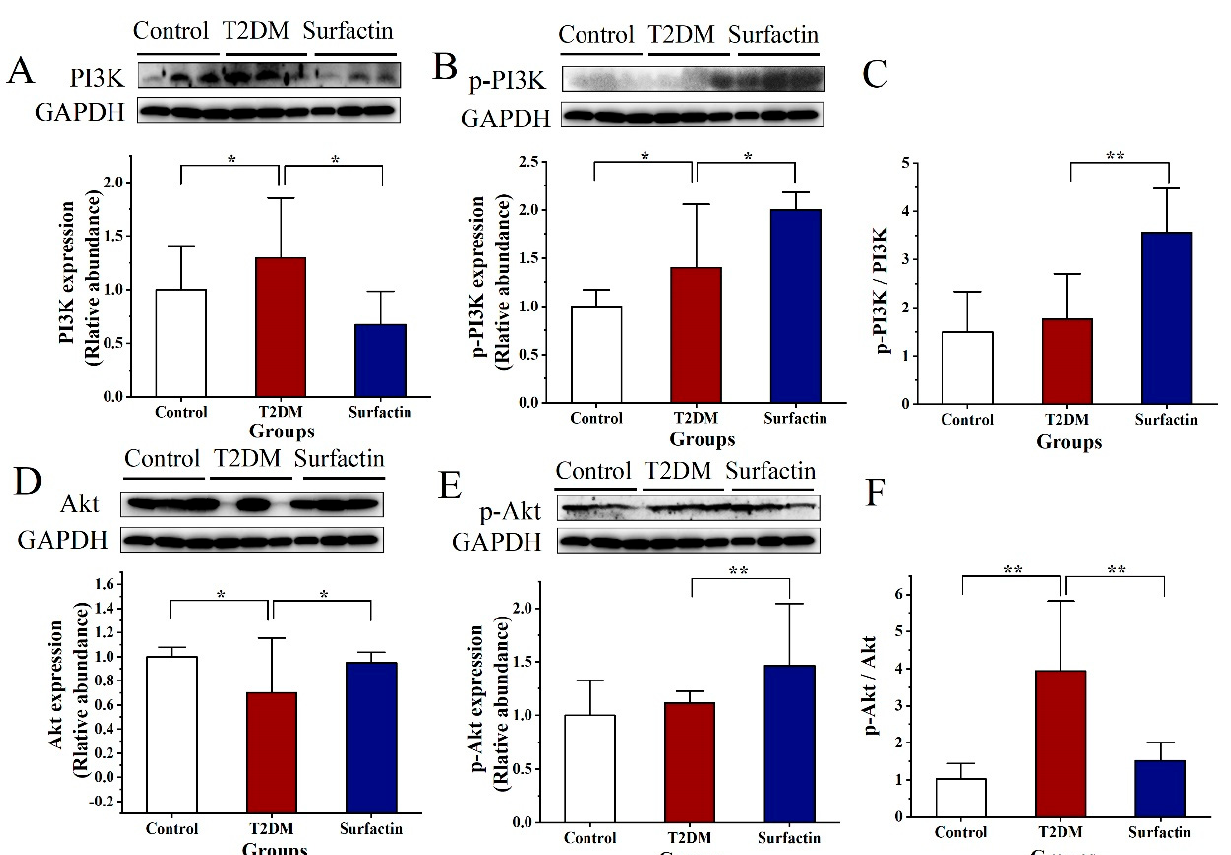
Figure 4. Effects of surfactin on proteins associated with glycometabolism of the pancreas in HFD/STZ-induced T2DM mice. The control group represents normal mice fed a basic diet, the T2DM group represents mice with T2DM induced by a 60% fat diet and 30 mg/kg body weight STZ, and the surfactin group represents T2DM mice treated with 80 mg/kg body weight surfactin. The levels of PI3K ( A ), p − PI3K ( B ), the ratio of p − PI3K to PI3K ( C ), Akt ( D ), p − Akt ( E ) and the ratio of p − Akt to Akt ( F ). * indicates significant differences at p < 0.05, ** indicates significant differences at p < 0.01.